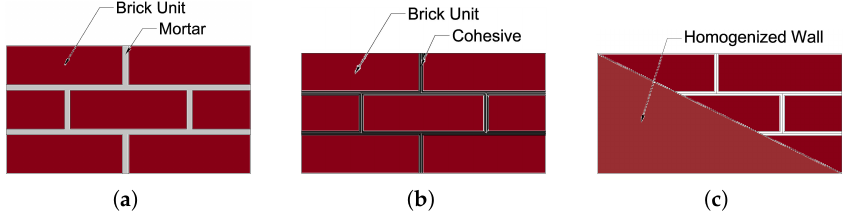
Figure 2. Schematic representation of the numerical model for masonry prisms with dimensions of 665 215 102.5 mm 3 : ( a ) URM prism; ( b ) masonry prism reinforced with Ni-Ti SMA stripes; × × ( c ) masonry prism reinforced with Cu-Zn-Al SMA stripes (SMA stripes range in thickness from 1 to 1.5 and 2 mm, respectively, with a width of 40 mm and height of 665 mm).